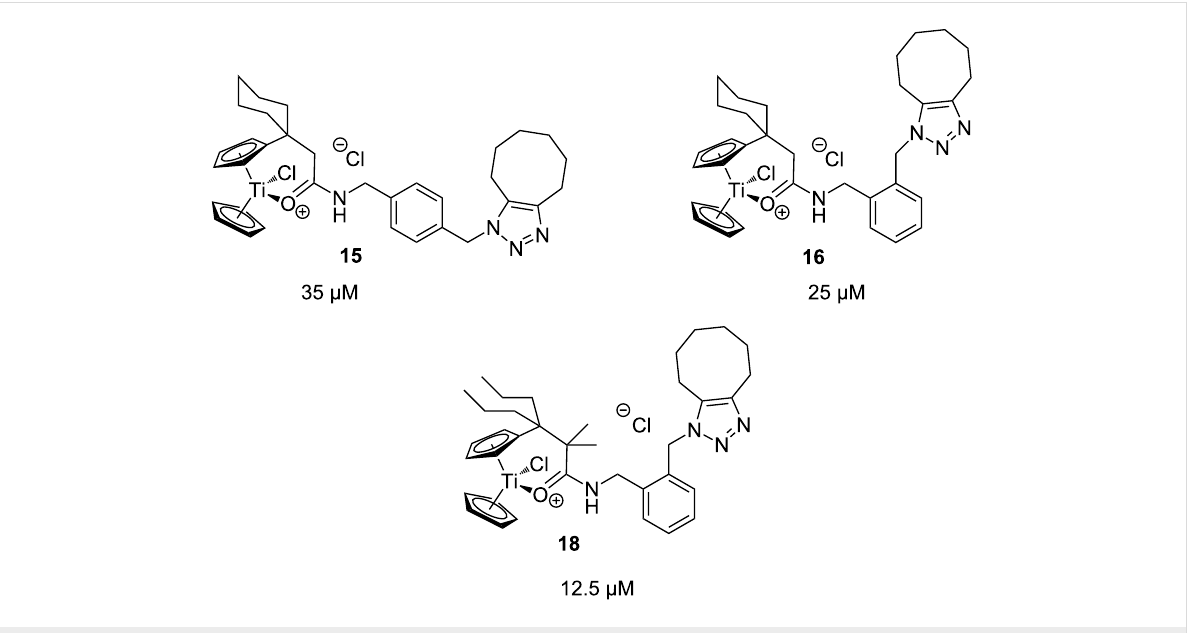
Figure 3: Most active titanocenes of this study and their AC 50 values.